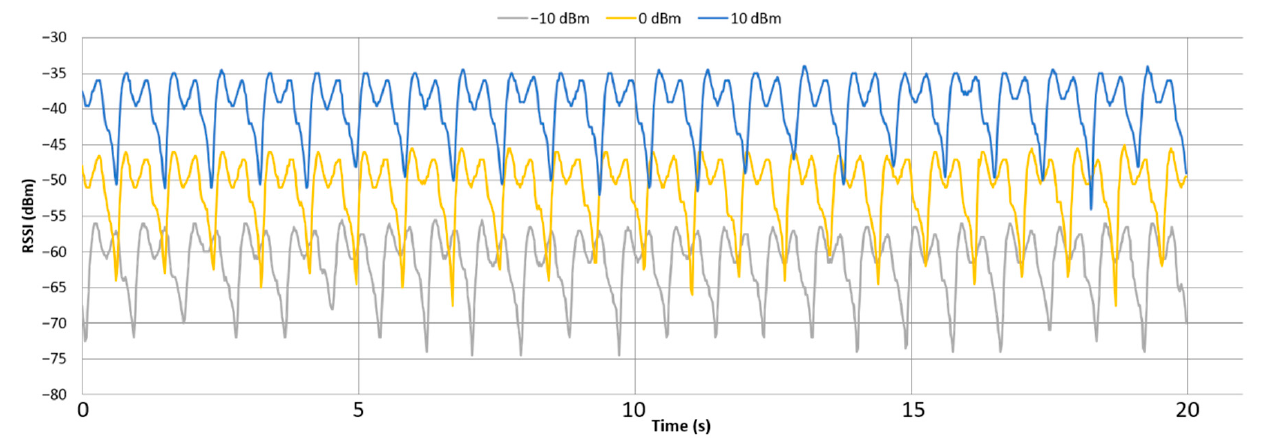
Figure 10. RSSI variation with time in the cycling scenario for the 433 MHz band for three different transmit power levels. The RSSI variation with time for the 868 MHz and 2.4 GHz band and a transmit power level of 0 dBm is presented in Figure 11. Particularly for the 2.4 GHz band, its lower RSSI and PRR values are reflected on the periodic shape, where the pedaling motion is not as easily recognizable. The distinctive peak shape with two contiguous maxima that is present in both sub-1 GHz frequencies, is not visible for this band. However, the maxima and minima corresponding to each pedal turn are easily observable, and the periodicity of the curve is still clear and can be exploited.